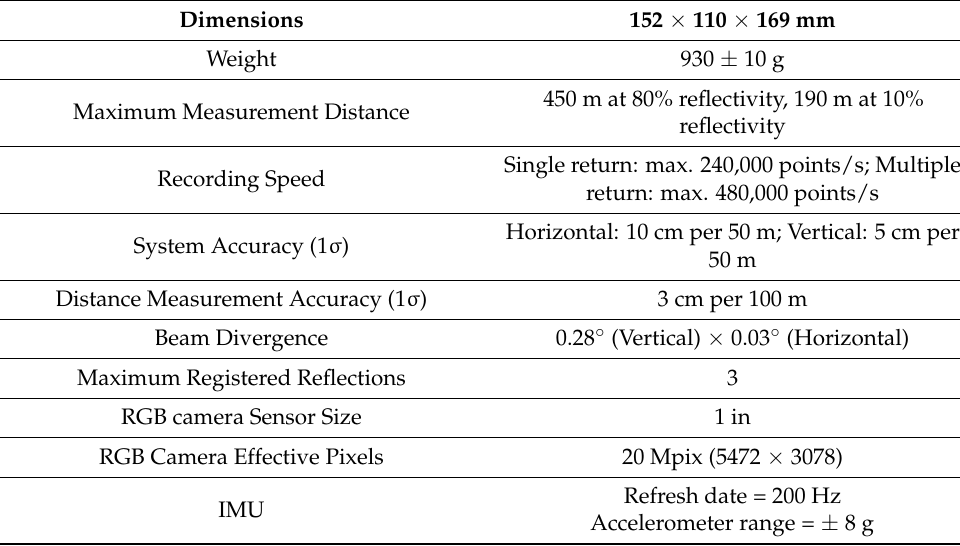
Table 4. Basic characteristics of the DJI Zenmuse L1 laser